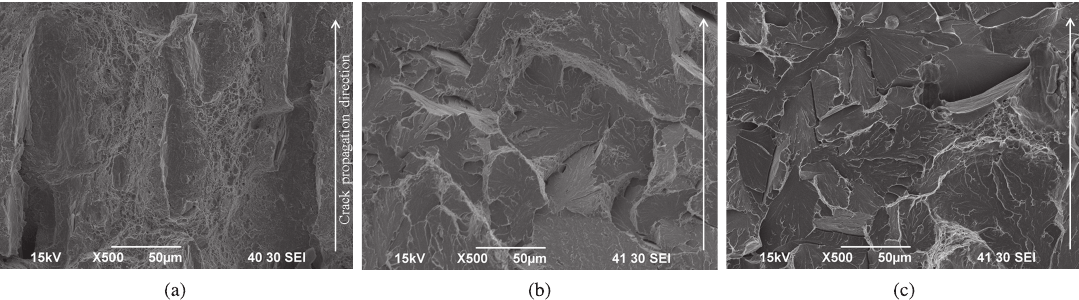
Figure 8. Fractography of fatigue fractured specimens for the HAZ at final fracture (Zone III): (a) dimple morphology and long thin hollows on the as-received condition, (b) normalized for 5 hours, and (c) normalized for 10 hours with brittle fracture showing defined cleavage facets and dimple network.